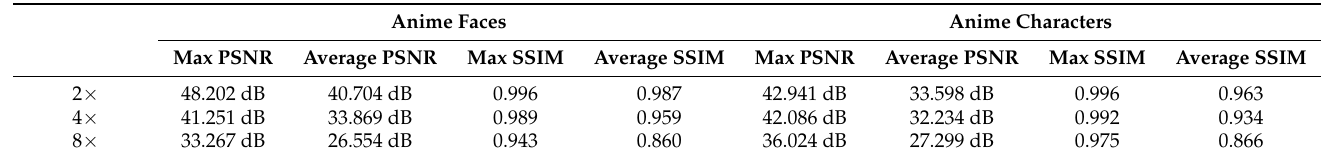
Figure 21. An example of visual result of an anime character on test dataset (Multi-level anime83). The red frame area is the hand details. Table 1. Results on anime faces (180 images, AnimeFace180) and characters (83 images, Multi-level